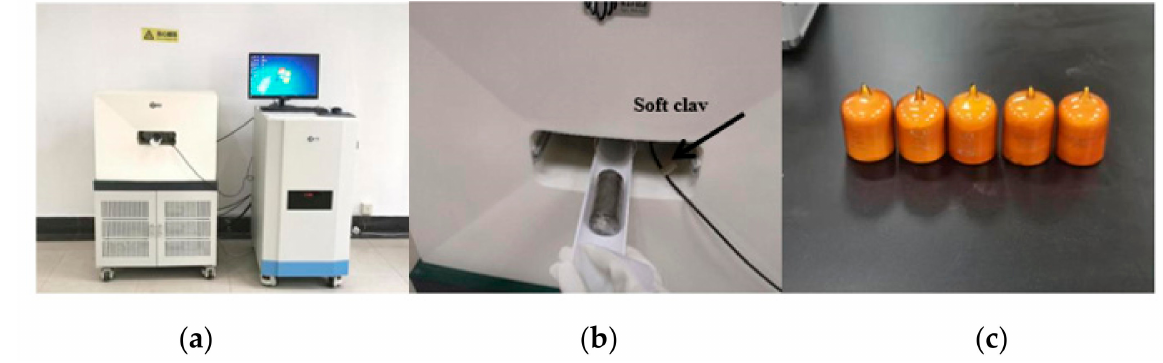
Figure 8. Nuclear magnetic resonance test: ( a ) apparatus, ( b ) soil sample, ( c ) standard sample.